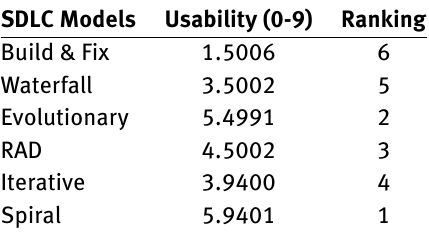
Table 6: usability & ranking of SDLC models